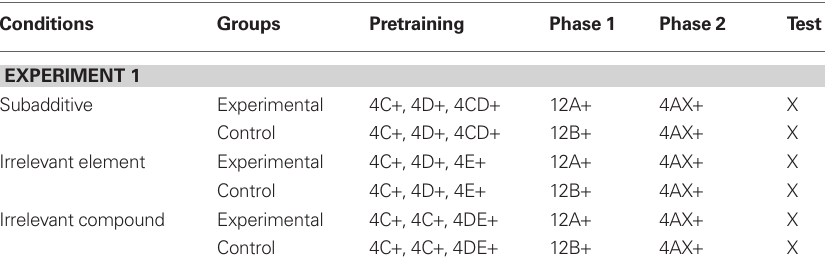
Table 1 | Experimental design of Experiment 1 Beckers et al. (2006).